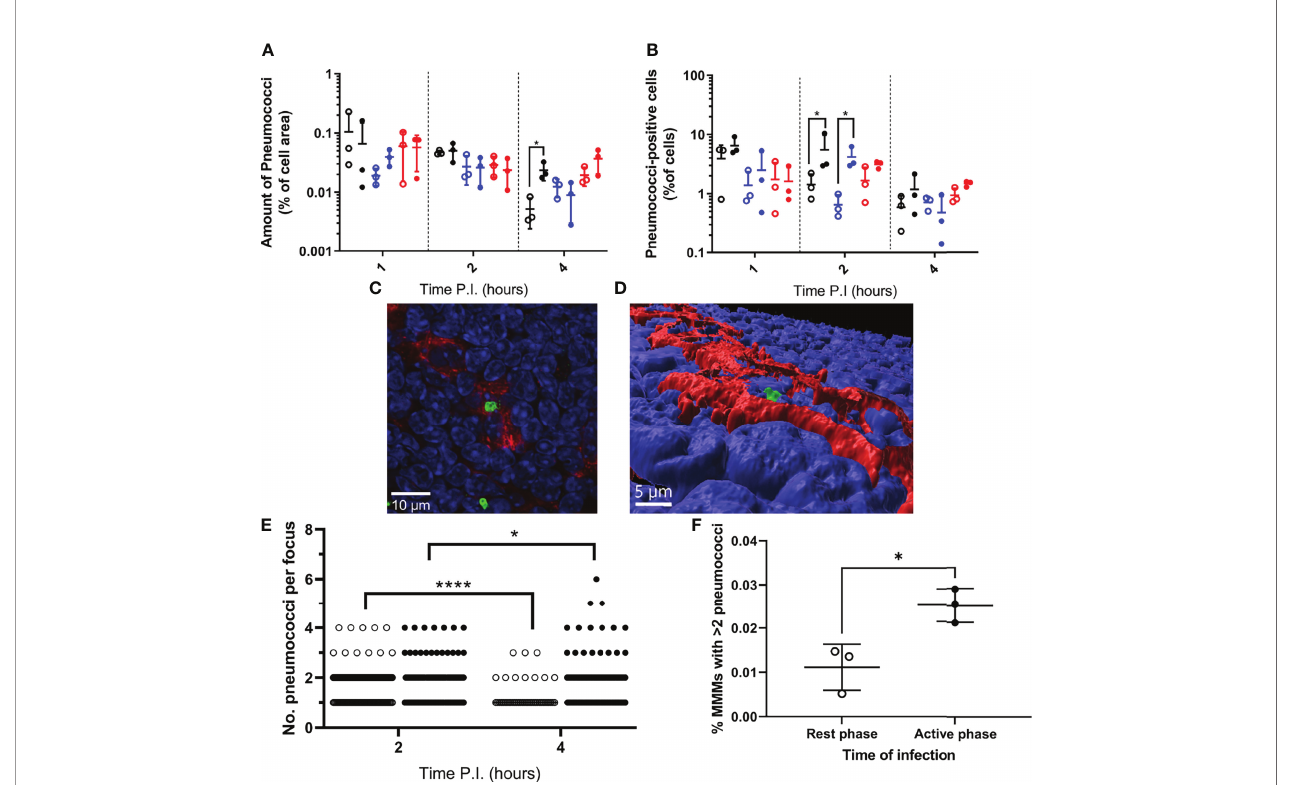
FIGURE 2 | Bacterial localisation and replication within splenic tissue resident macrophages. Spleens from 3 mice per time point per group (n=18) were sectioned and stained for immunohistochemistry to identify MMMs (CD169+), MZMs (MARCO+) and RPMs (F4/80+). (A, B) Whole sections were scanned and analysed to determine the area of pneumococci associated with each macrophage subtype, which is expressed as a percentage of the macrophage area (A) and the percentage of cells of each macrophage subtype that are associated with pneumococci (B) . MMMs, MZMs and RPMs are represented by black, blue and red points respectively. Rest and active phase-infected mice are represented by open and fi lled points respectively. Statistical signi fi cance was determined at each time point by Mann- Whitney test between both groups of mice for each macrophage subtype (*; P ≤ 0.05). (C) Confocal single optical section image of a 6-pneumococci cluster associated with a MMM at 4h PI showing cell nuclei (blue), CD169 (red) and pneumococci (green). The scale bar represents 10µm. (D) 3D-reconstruction of (C) showing the pneumococcal cluster (green) within the con fi nes of CD169+ signal (red) verifying intracellularity. Nuclei are shown in blue. The scale bar represents 5µm. (E) 2 and 4h PI spleen samples stained to visualise MMMs were manually analysed using confocal microscopy. The number of intracellular pneumococci within MMMs were recorded. Rest and active phase-infected mice are represented by open and fi lled points respectively. Statistical signi fi cance was determined between time points for each group by Mann-Whitney test (*P=0.0327; ****P<0.0001). (F) Whole sections analysed in (E) were re-analysed to determine the number of MMMs within each section. The total number of pneumococcal clusters consisting of 3 or more bacteria was normalised against the total number of MMMs to give the percentage of MMMs that contain replicative foci at 4h PI. Rest and active phase-infected mice are represented by open and fi lled points respectively. Statistical signi fi cance was determined Mann-Whitney test